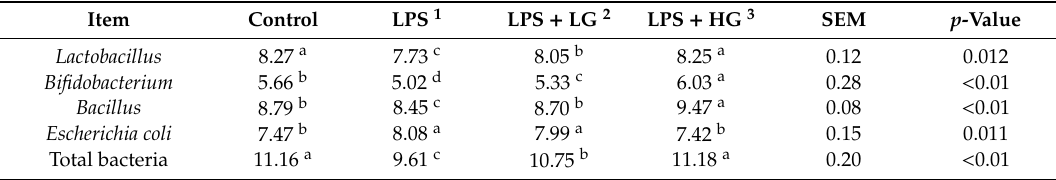
Figure 2. mRNA expression level of MUC1 and MUC2 in the jejunal mucosa of piglets fed diets with two molecular weight β -glucans. Data are shown as means ± SE. ( A ) MUC1 mRNA expression level. ( B ) MUC2 mRNA expression level. Di ff erent letters indicate statistically significant di ff erences between groups ( p < 0.05). Control: Sterile saline solution injection group fed basal diet; LPS:LPS injection group fed basal diet; LPS + LG:LPS injection group fed low molecular weight β -glucan; LPS + HG:LPS injection group fed high molecular weight β -glucan. n = 8 replicates per group. Table 9. Colonic microflora of piglets fed di ff erent molecular weight β -glucan (Unit: Lg copies / gram of dry digesta).